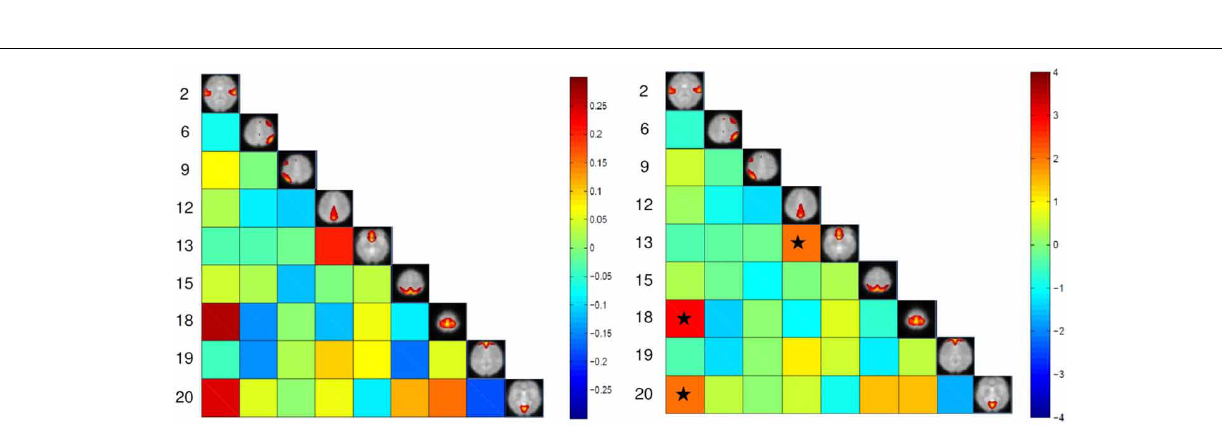
FIGURE 4 | Left: Mean correlation difference between control subjects and patients (control-patient). Right: T -value resulting from two sample t -test with p -value threshold of 0.05 corrected for FDR. Stars show pairs that survived the paired t